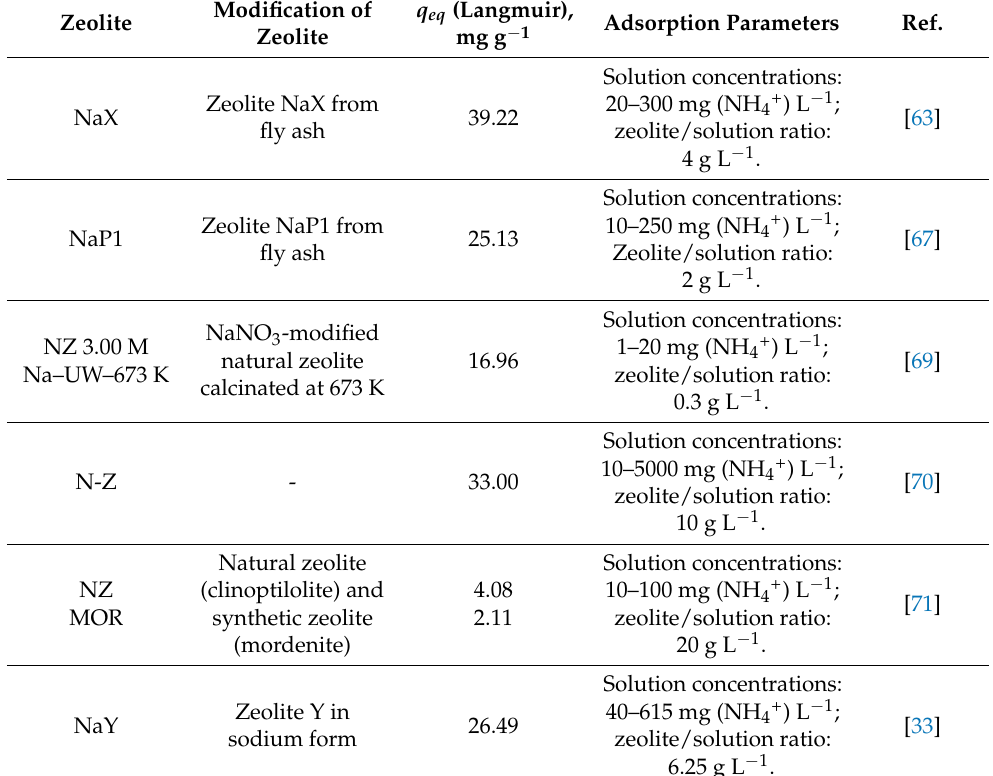
Table 6. Comparison of zeolite adsorption capacities toward NH 4+ ions.